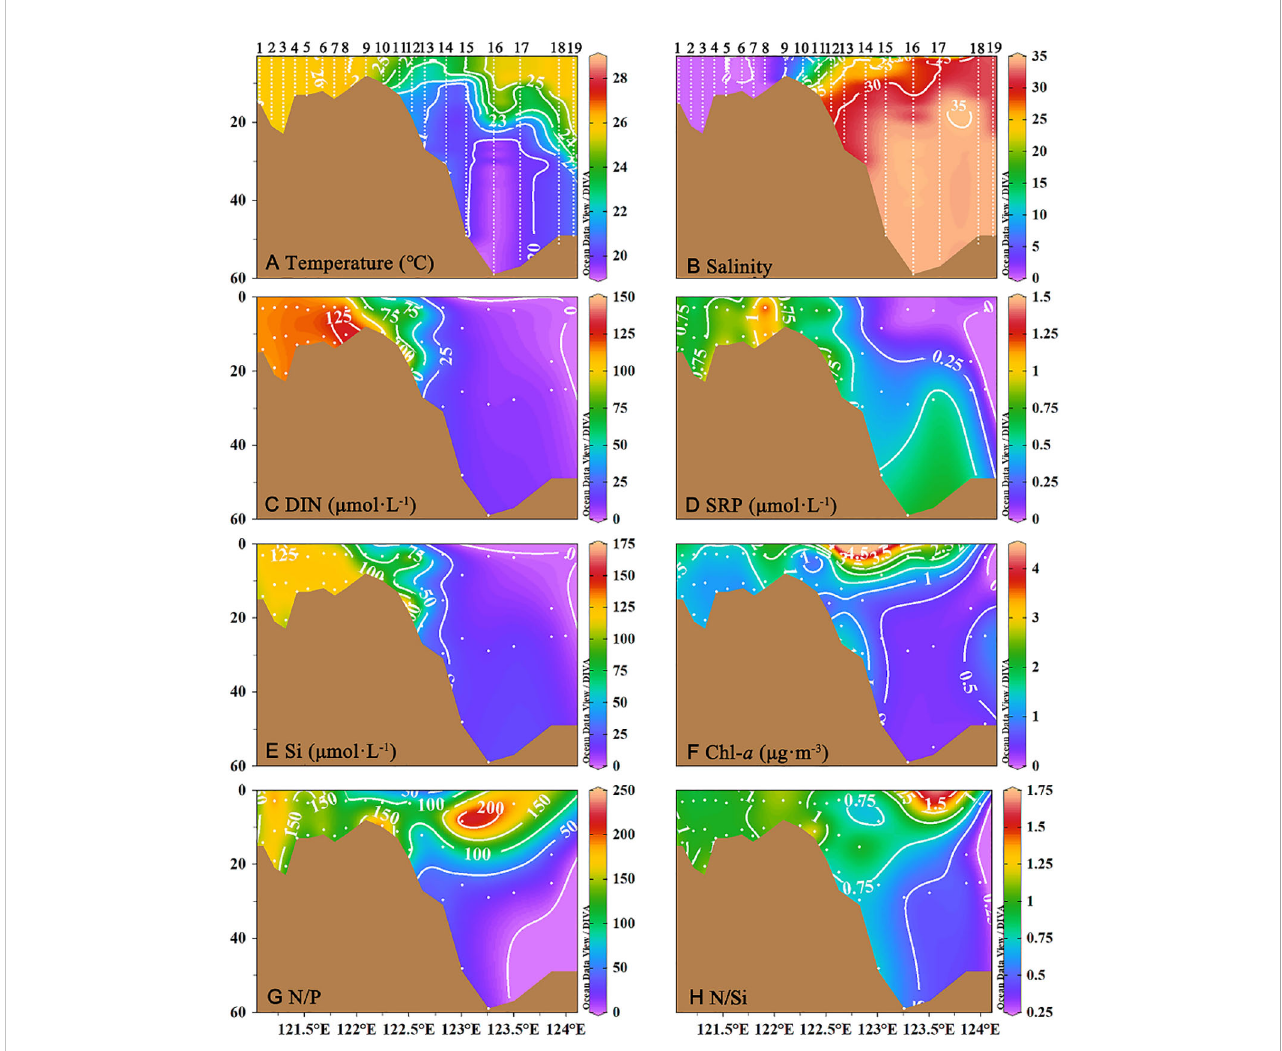
FIGURE 3 The vertical pro fi les of (A) temperature (°C), (B) salinity, (C) dissolved inorganic nitrogen (DIN, m mol/L), (D) Soluble reactive phosphorus (SRP, m mol/L), (E) silicate ( m mol/L), (F) chlorophyll a (Chl- a , m g/m -3 ), (G) DIN : SRP ratios (N:P), (H) DIN : Si ratios (N:Si) from transect C in the southern branch of the Changjiang River Estuary and the East China